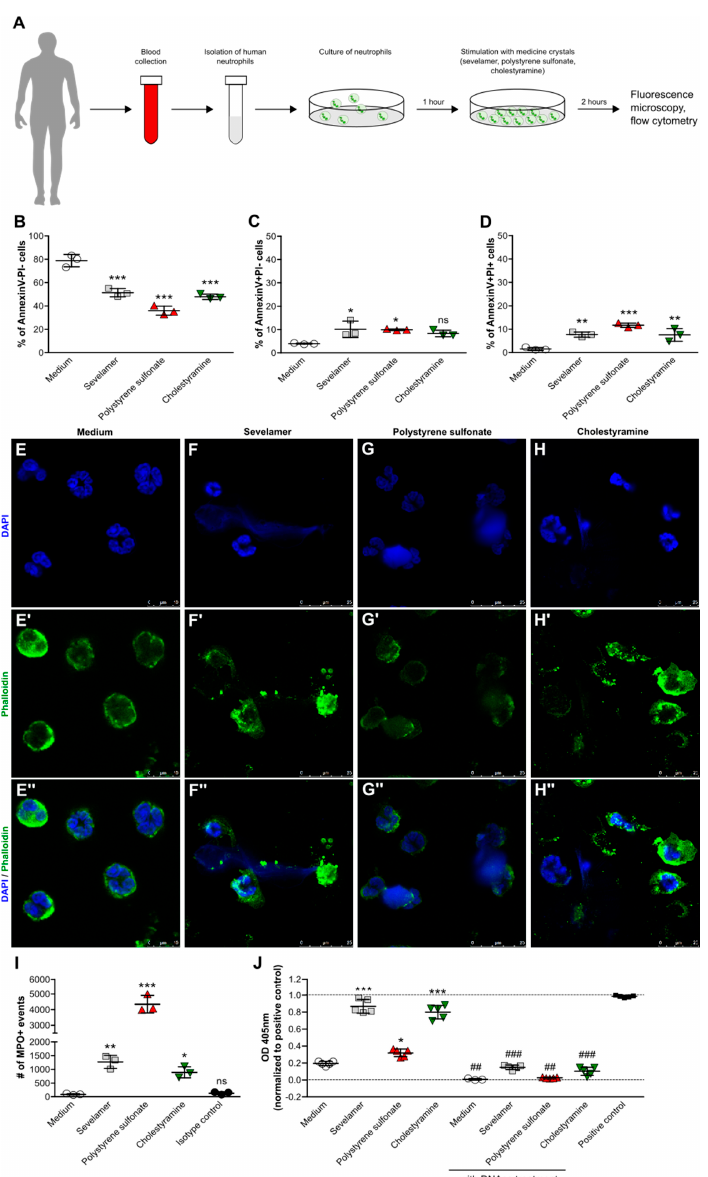
Figure 5. Crystals of ion-exchange resins induce neutrophil extracellular trap formation. ( A ) Schematic showing work flow. Human blood neutrophils were isolated from healthy individuals and stimulated with or without sevelamer, polystyrene sulfonate, or cholestyramine crystals (1000 µ g / mL) for 2 h. ( B – D ) After stimulation, the percentage of live (AnnexinV-PI-) ( B ), apoptotic (AnnexinV + PI-)( C ), and late apoptotic / necrotic (AnnexinV + PI + ) ( D ) neutrophils was quantified by flow cytometry ( n =